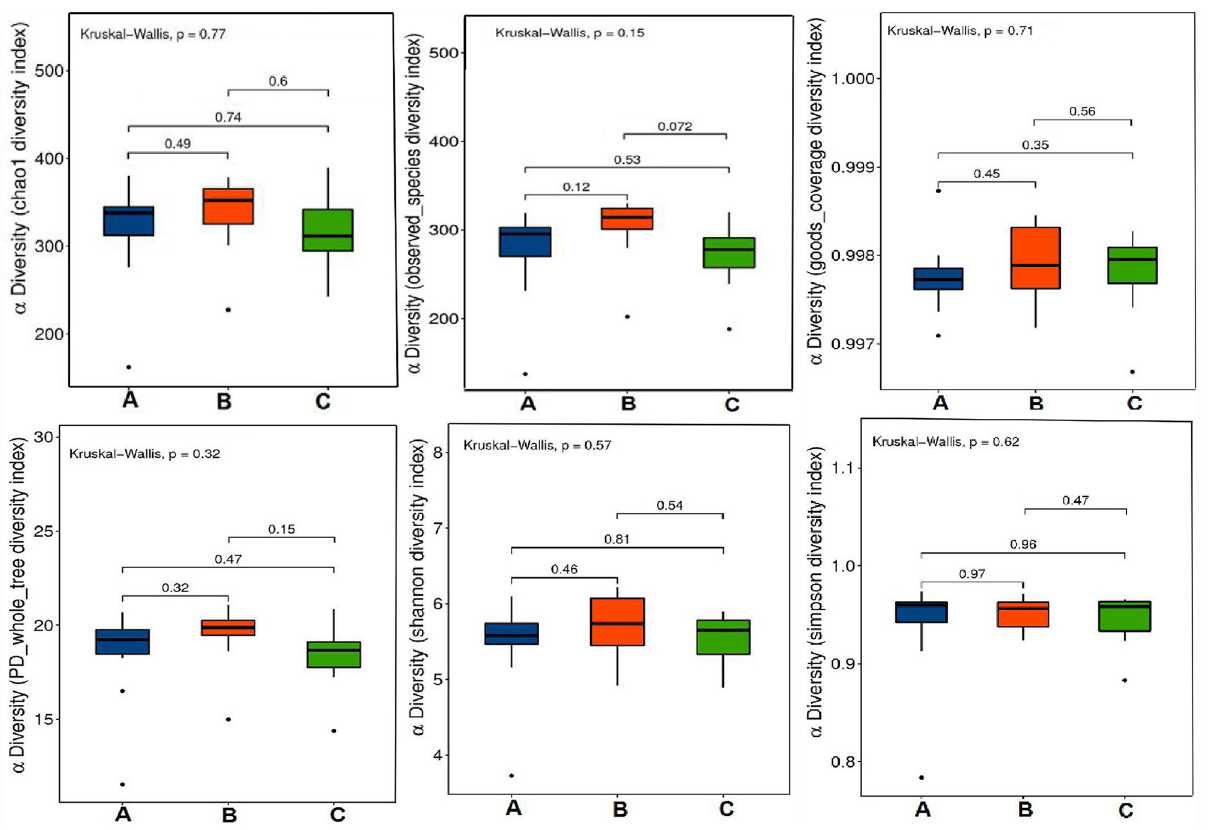
Figure 10. Alpha-diversity boxplots in Normal group, Model group and HD of SLM group, such as Chao1 ( a ), Observed ( b ), Goods_coverage ( c ), PD_whole_tree ( d ), Shannon ( e ), and Simpson indexes ( f